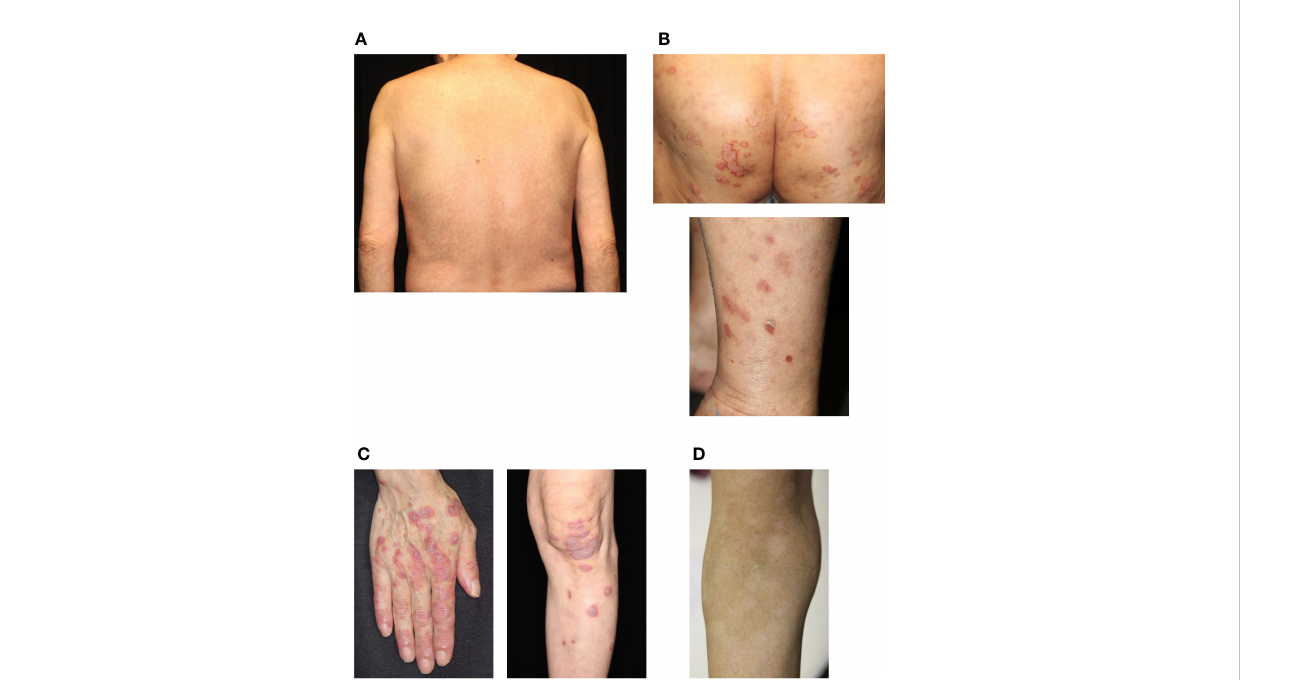
FIGURE 1 Common cutaneous irAEs. (A) Maculopapular rash. Erythematous macules and papules on the trunk. (B) Psoriasiform eruption. Scaly keratotic erythema plaques on the gluteal region and lower limbs. (C) Lichen planus-like eruption. Erythematous patches with scale and hyperkeratosis on the hands and lower limbs. (D) Vitiligo. Depigmented macules developing into plaques on the forearm. irAEs, immune-related cutaneous adverse events. Written informed consent was obtained from the individual(s) for the publication of any identi fi able images or data included in this